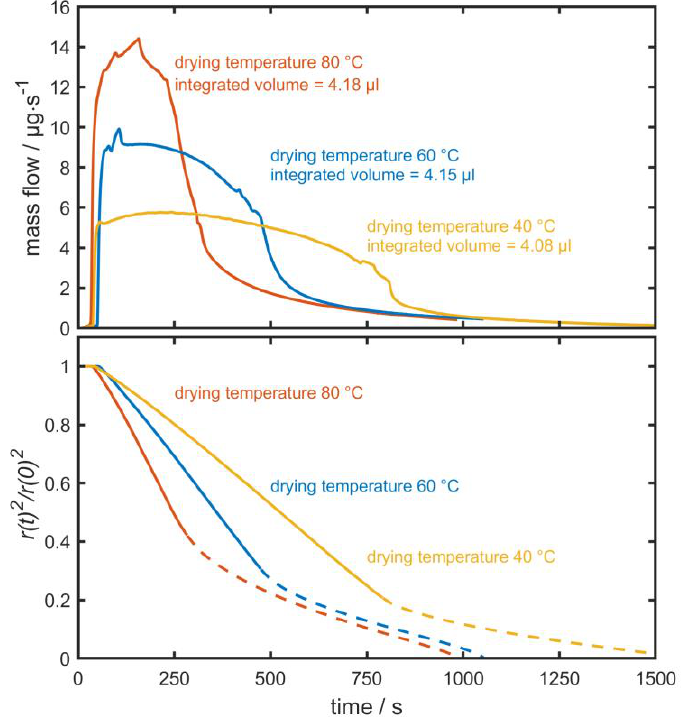
Figure 6. Top : Measured H 2 O mass flow of levitated 10 wt% lysozyme solution droplets at different drying temperatures (80 ◦ C (red), 60 ◦ C (blue) and 40 ◦ C (yellow)) and a nitrogen flow rate of 1.0 nL/min; the dashed lines do not show the real physical behavior of the droplet radius after the critical point of drying, but are only given for completeness. Bottom : Calculated normalized squared equivalent radius of the evaporating protein solution droplets at different drying temperatures (80 ◦ C (red), 60 ◦ C (blue) and 40 ◦ C